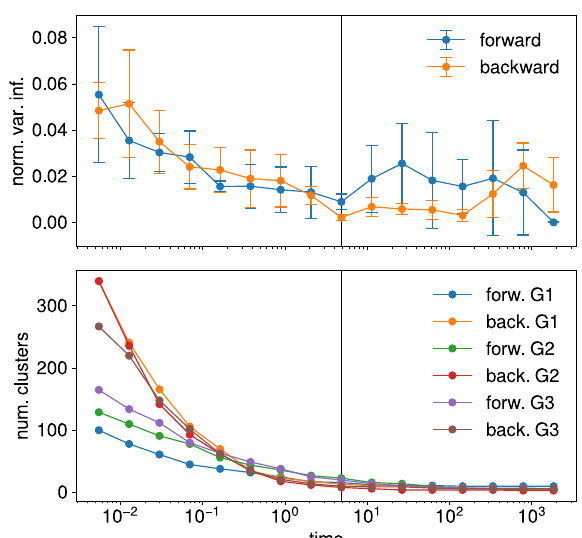
Fig. 2 Scan in resolution of the flow stability method. Normalized variation of information of the results as a function of the duration of the diffusive process (top). The average and standard deviation computed across the three networks are shown. Number of clusters in the best forward and backward partitions as a function of the time (bottom). The time plays the role of a resolution parameter